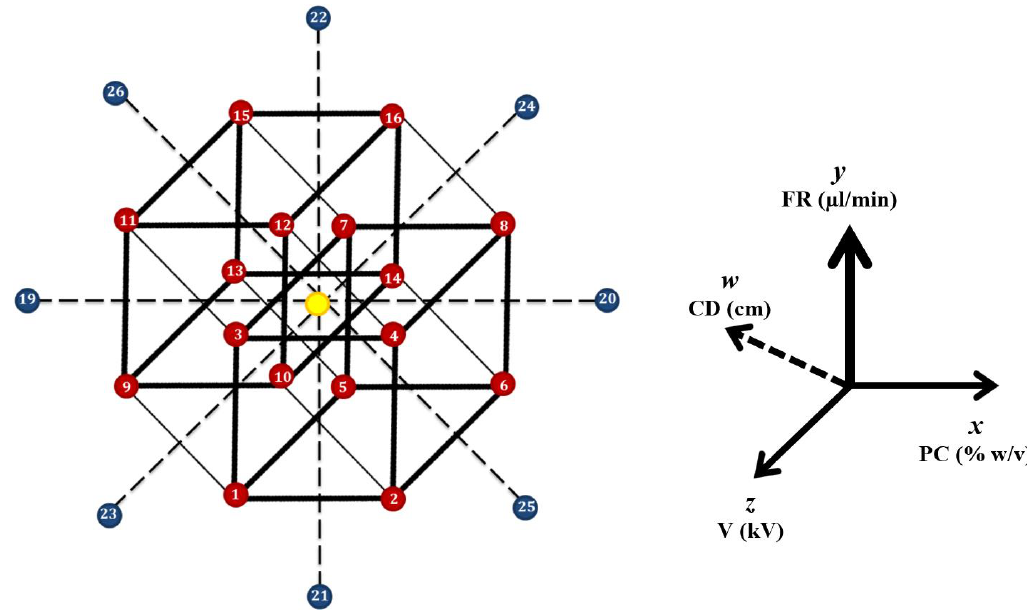
Figure 1. Schematic illustration of the design space of experiments as a function of x (polymer concentration), y (flow rate), z (applied voltage), and w (collector distance). The red points represent the 16 cube points (runs 1–16), the blue points represent the 8 axial points (runs 19–26), and the yellow point represents the center point’s replicates (runs 17, 18, 27, and 28).